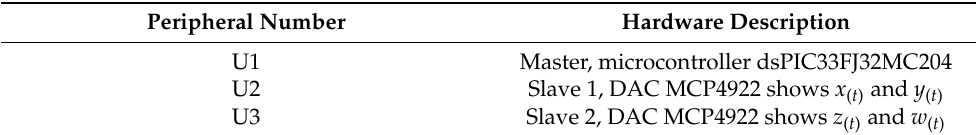
Table 2. Data bus description of embedded system (ES).